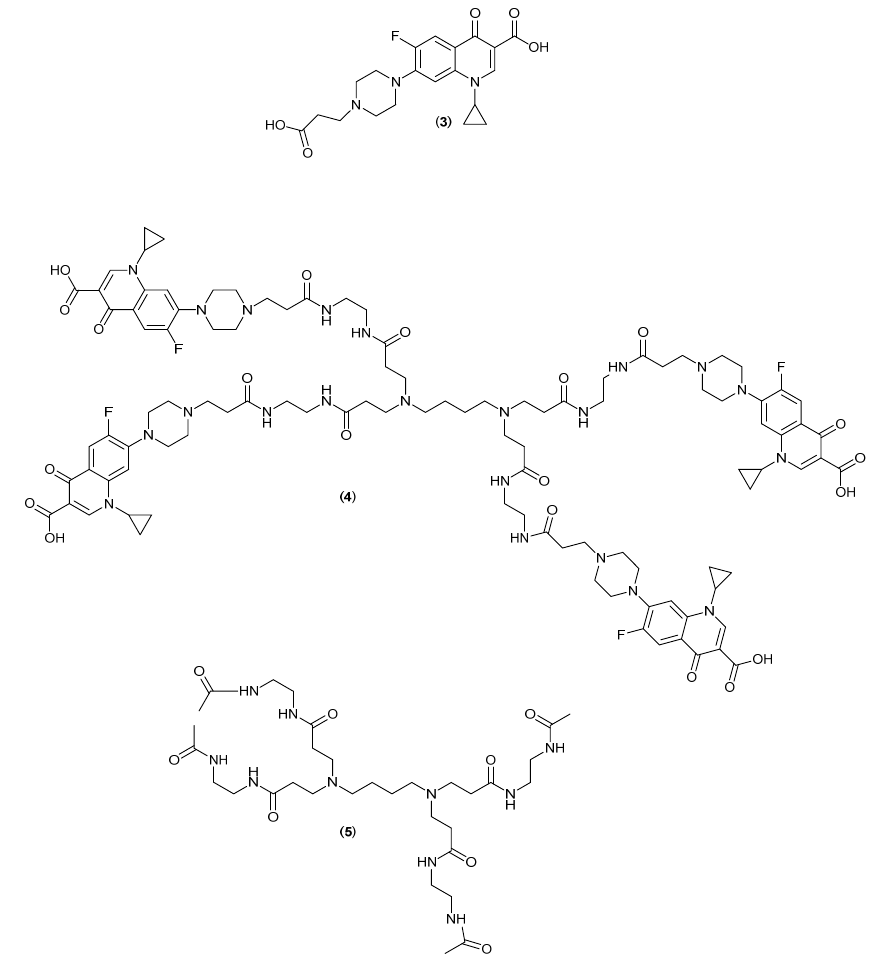
Figure 2. Ciprofloxacin ( 1 ) and the PAMAM-dendrimer ( 2 ).